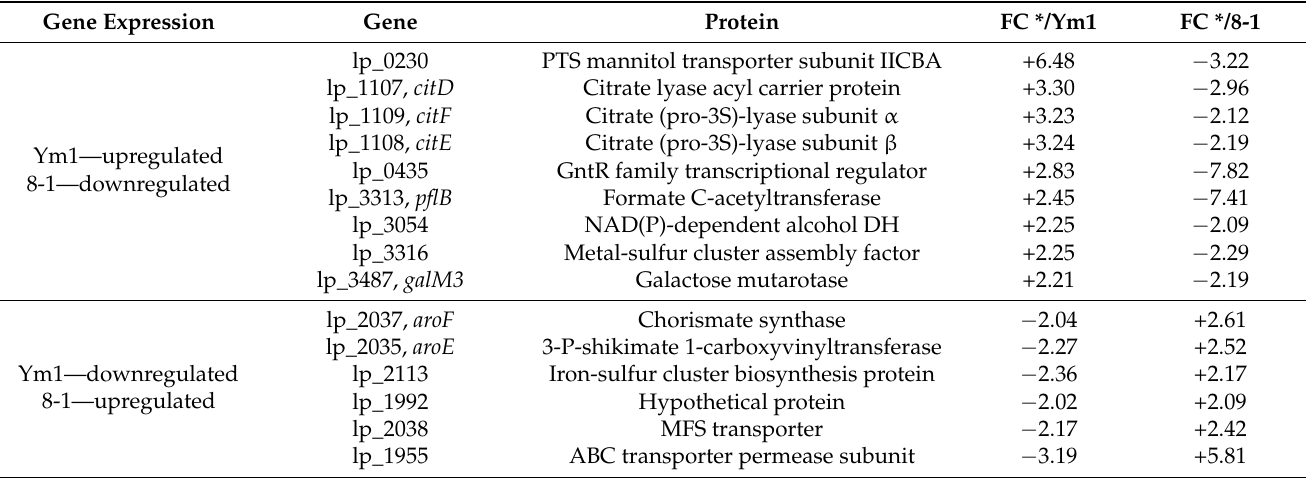
Table 1. Differentially expressed genes (DEGs) of L. plantarum strains under butanol stress that were regulated in opposite directions. The strain Ym1 is highly resistant to butanol, whereas the strain 8-1 is moderately sensitive. Gene Expression